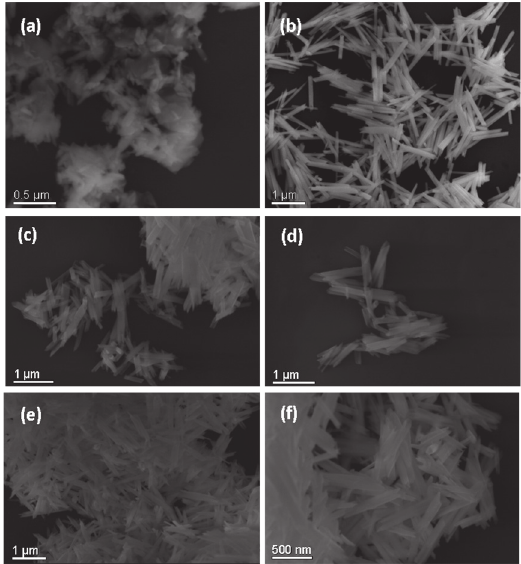
without 3 O 2 3